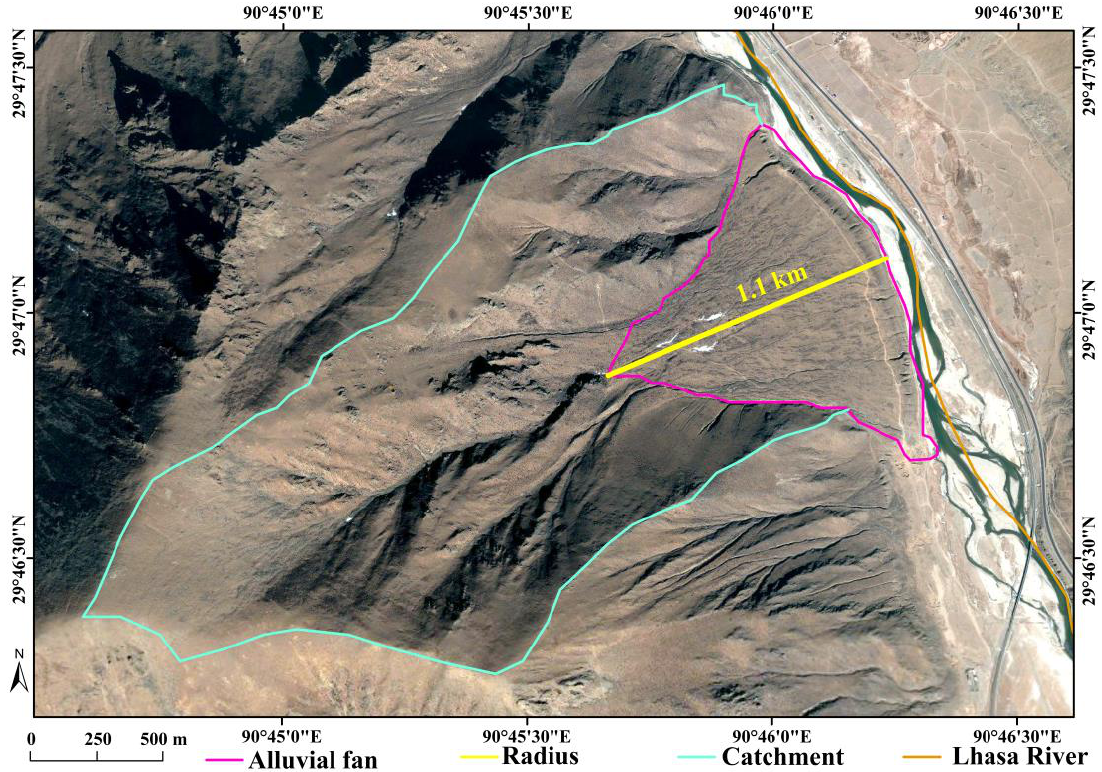
Figure 8. Alluvial fan located in Niezu Village, Duilong Deqing District.